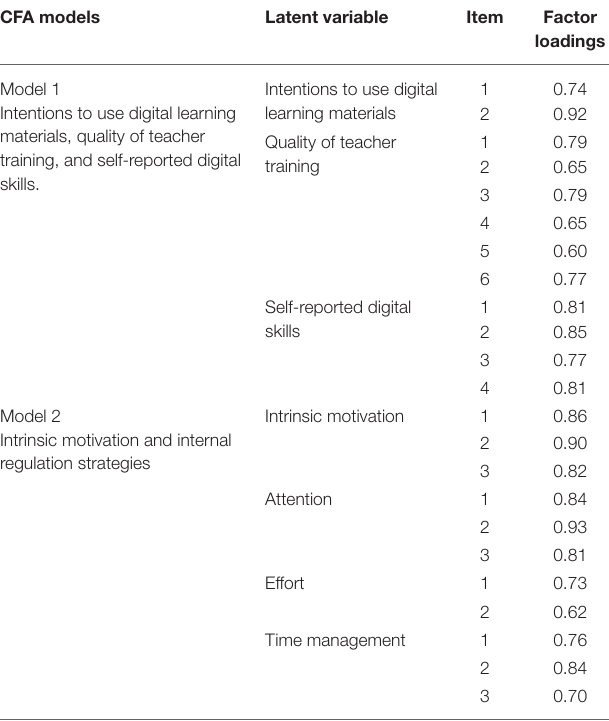
TABLE 2 | Standardized factor loadings for the items in the CFA models. CFA